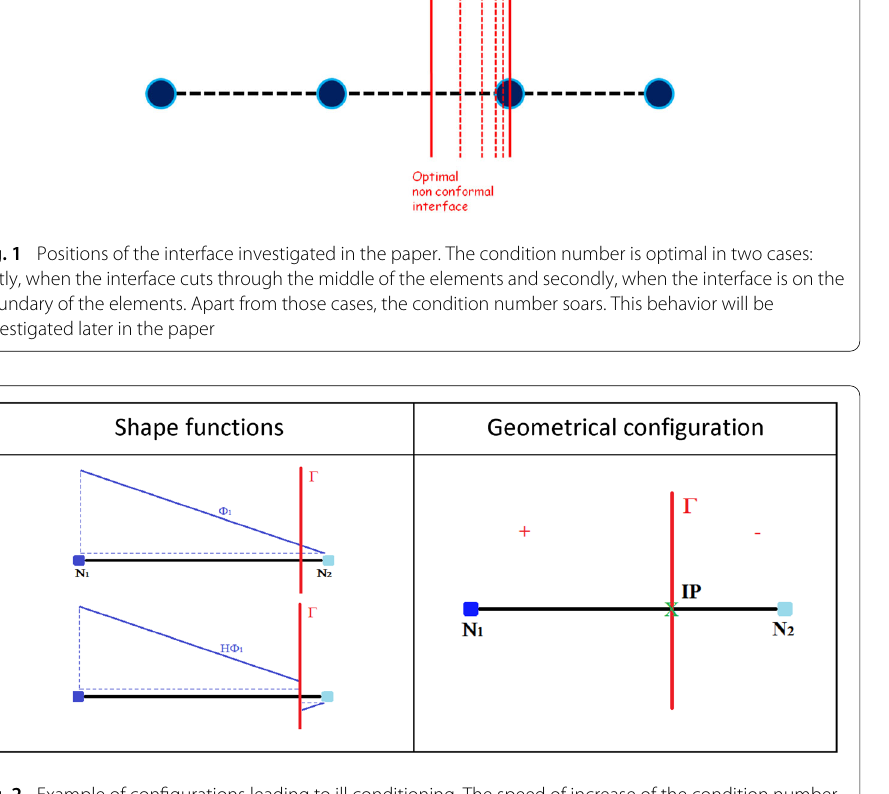
Fig. 2 Example of configurations leading to ill conditioning. The speed of increase of the condition number is related to the distance between the interface and the nodes of the mesh. The condition number soars when either the distance N 1 IP goes to zero or when N 2 IP goes to